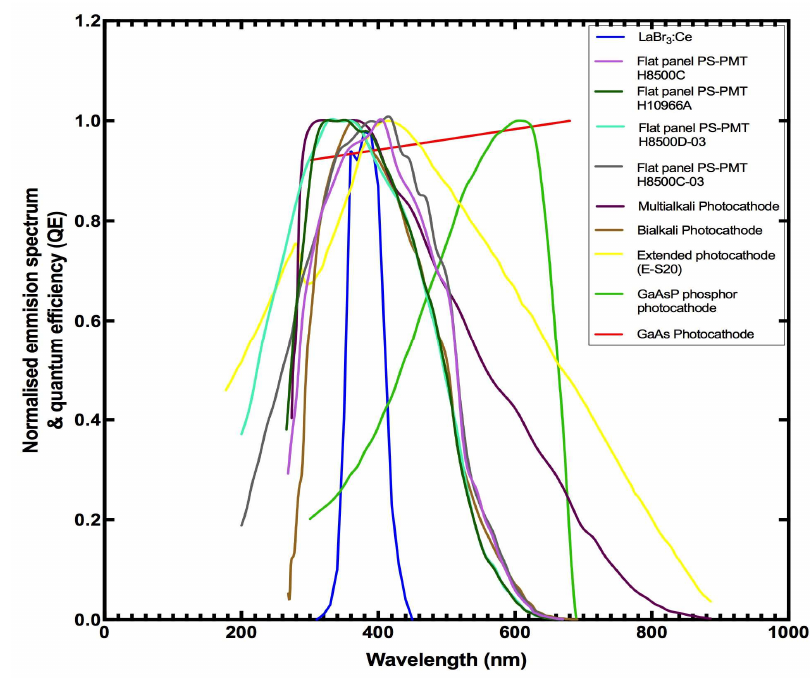
Figure 9. Optical spectra distribution of LaBr 3 :Ce, and spectral sensitivity of photocathodes.